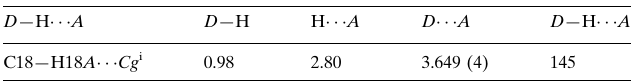
Hydrogen-bond geometry (A˚ , (cid:2)